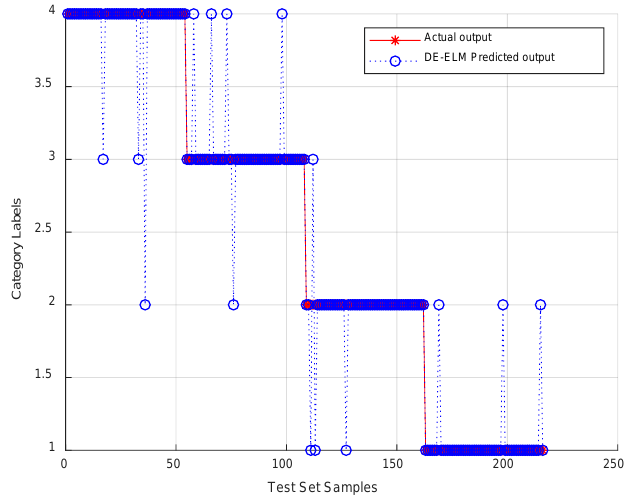
Figure 12. ELM (200 nodes)-based fatigue state detection results.